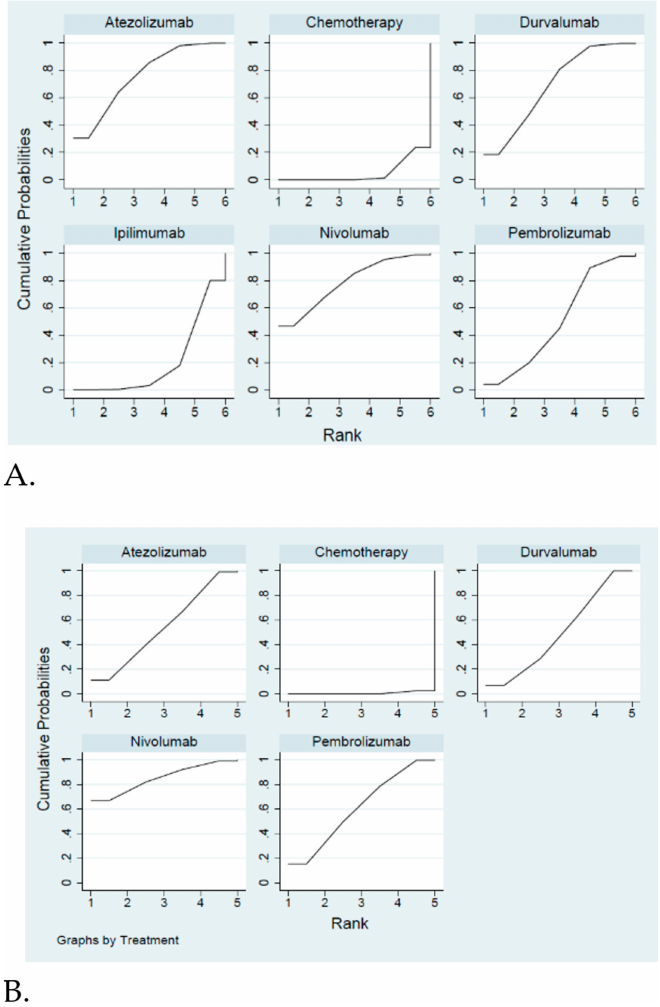
Figure 3. Summary of e ff ect sizes from pairwise comparisons. ( A ) Hazard Ratio for overall survival; ( B ) Hazard Ratio for progression free survival; ( C ) Response Ratio for objective response rate; ( D ) Risk Ratio for grade 3–4 adverse